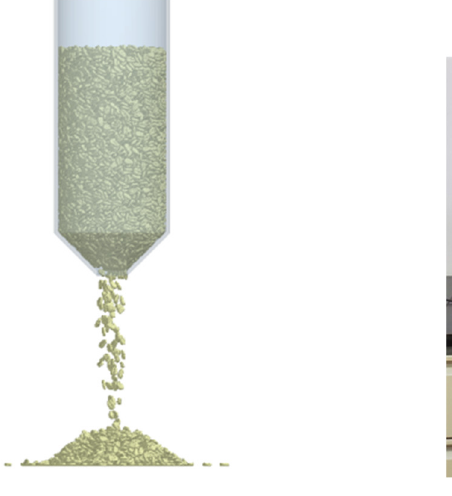
Figure 5. Simulation of corn grain flow and high-speed camera test: ( a ) EDEM simulation; ( b ) high-speed camera test. 1. PC; 2. Bench; 3. Vertical grain cylinder model; 4. High-speed camera.